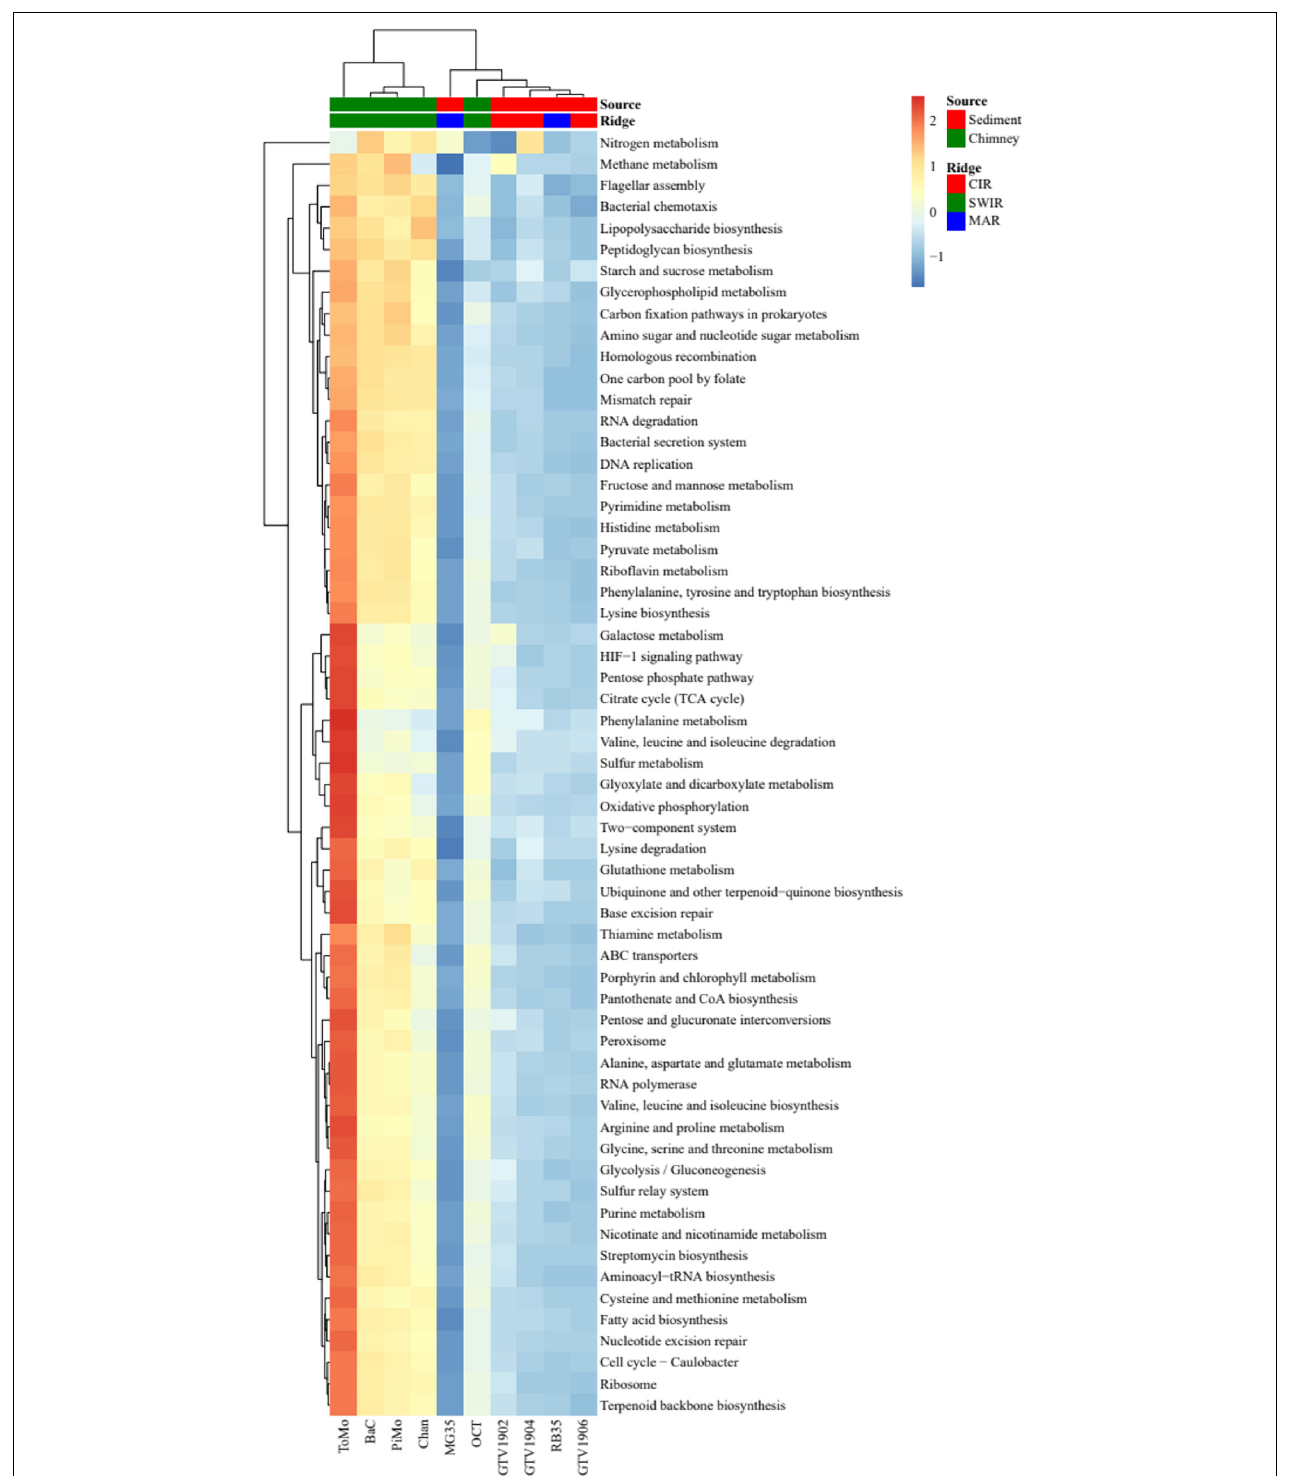
FIGURE 4 | Two-way cluster analysis of samples and level 3 KEGG pathways based on the relative abundances of the KEGG-annotated sequences with hits in each category. The heatmap was clustered based on the Euclidean distance matrix. The shading is proportional to the normalized values calculated based on the functional hits of each category per sample. Only pathways with sum of hits > 186,000 across the 10 metagenomes are shown.